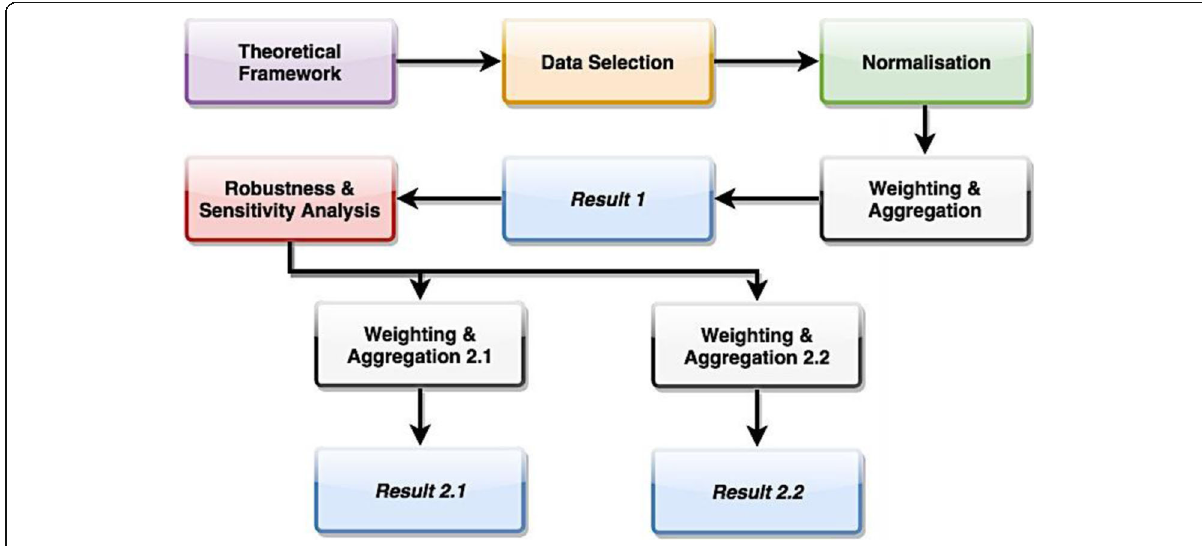
Fig. 1 Methodology steps (author ’ s